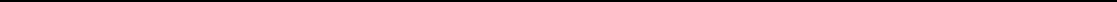
Fig. 4 HBV subverts hepatocyte-intrinsic innate immune responses. a , b Analysis of the induction of p38, ERK1/2, JNK1/2/3, STAT2, and HSP60 phosphorylation following stimulation of uninfected or patient-derived HBV-infected 3D PHH cultures (100 GE/cell) with 1 μ M myristoylated preS1 peptide for 24 h using phospho-kinase arrays. Cells were treated/infected 3 days post-seeding of PHH and phosphorylation was determined 24h later. c – f Transcriptional pro fi le of c type I and e III IFN and d , f ISG within the fi rst 48 h after infection. g – k mRNA expression of g TLR1, h TLR2, i TLR8, j DDX58/ RIG-I, and k IRF3 in 3D PHH cultures, either left uninfected, infected with 100 GE/cell patient-derived HBV, or HBV-infected cultures treated with 1000 IU/ mL IFN α at 10 days postinfection. l Expression of ISG in 3D PHH cultures infected with patient-derived HBV (100 GE/cell), either untreated or treated with 1000 IU/mL IFN α at 10 days postinfection. m – o Inactivation of patient-derived HBV by 4% paraformaldehyde for 1 h, heat treatment at 98 degrees for 2 min, or exposure to UV irradiation for 30 min and resulting innate immune activation as measured by m HBsAg secretion 10 days after culture initiation and qPCR of n IFI27 and o IFITM3. All data shown are mean ± SD of three to six independent experiments (* p < 0.05, ** p < 0.01, *** p < 0.001; two-way ANOVA with Bonferroni